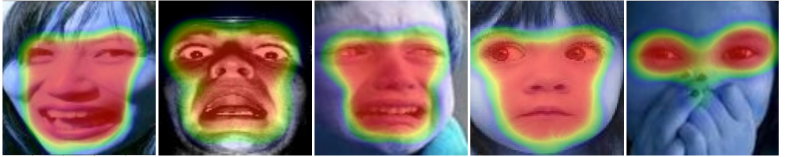
Figure 4. Images from the RAF-DB dataset. The heat map results show that the key pixels are concentrated in the eyes, nose, and mouth, which proves the effectiveness of our key